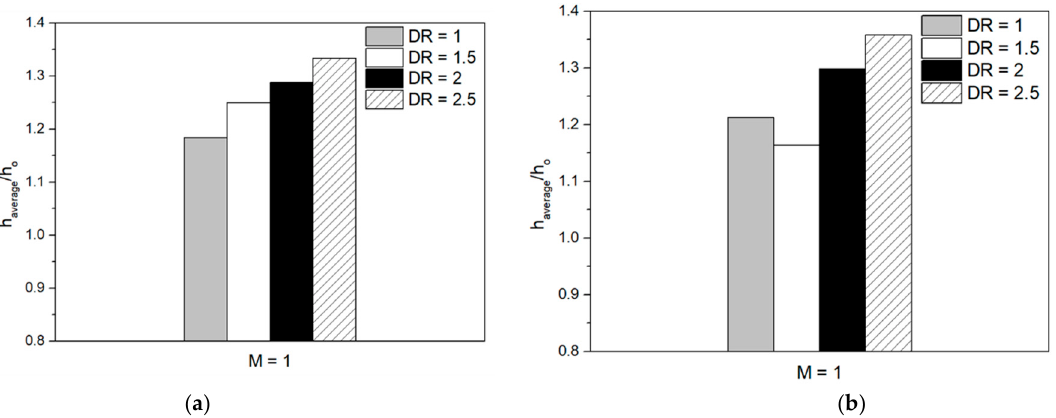
Figure 18. h average /h o for different density ratios: ( a ) M = 1.0; and ( b ) M = 2.0.